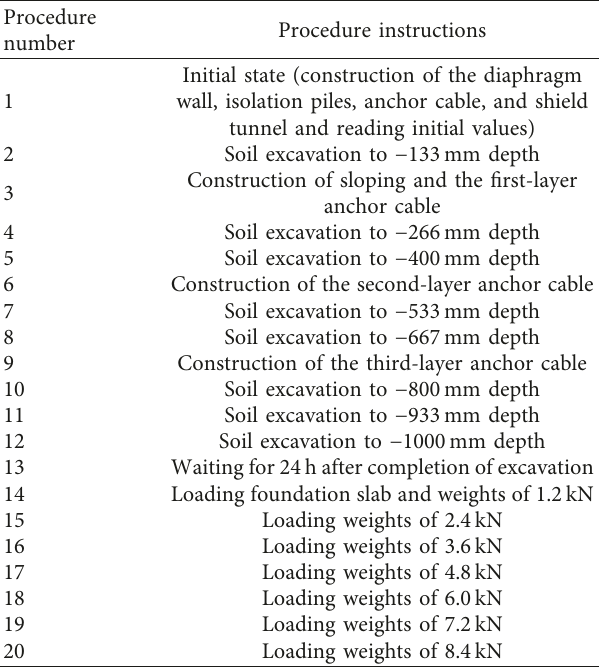
Table 5: Procedures of the model test.